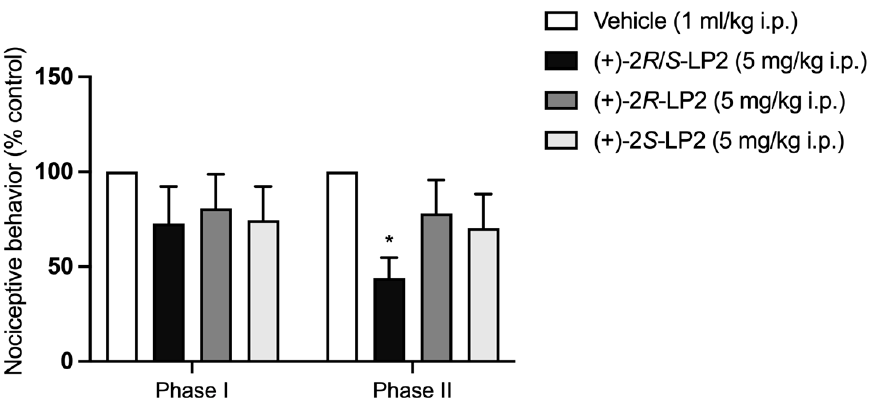
Figure 4. (+)-2 R / S -LP2 reduced nociceptive behaviour in the mouse formalin test. Intraperitoneal administration of (+)-2 R / S -LP2 (5 mg/kg) was able to decrease nociceptive behaviour only in the second phase of the mouse formalin test, while intraperitoneal administration of (+)-2 R -LP2 (5 mg/kg) and (+)-2 S -LP2 (5 mg/kg) did not differ significantly from the vehicle. Results are expressed as mean ± SEM ( n = 6–8 mice per group) and are represented as the percentage of inhibition of pain responses of the respective vehicle group (100%). * p < 0.05 vs. Vehicle, two-way ANOVA followed by Bonferroni post-hoc test. In inflammatory pain, spinal cord neuronal sensitization occurs during the second phase of the formalin test. As NMDA receptor activation plays an important role in